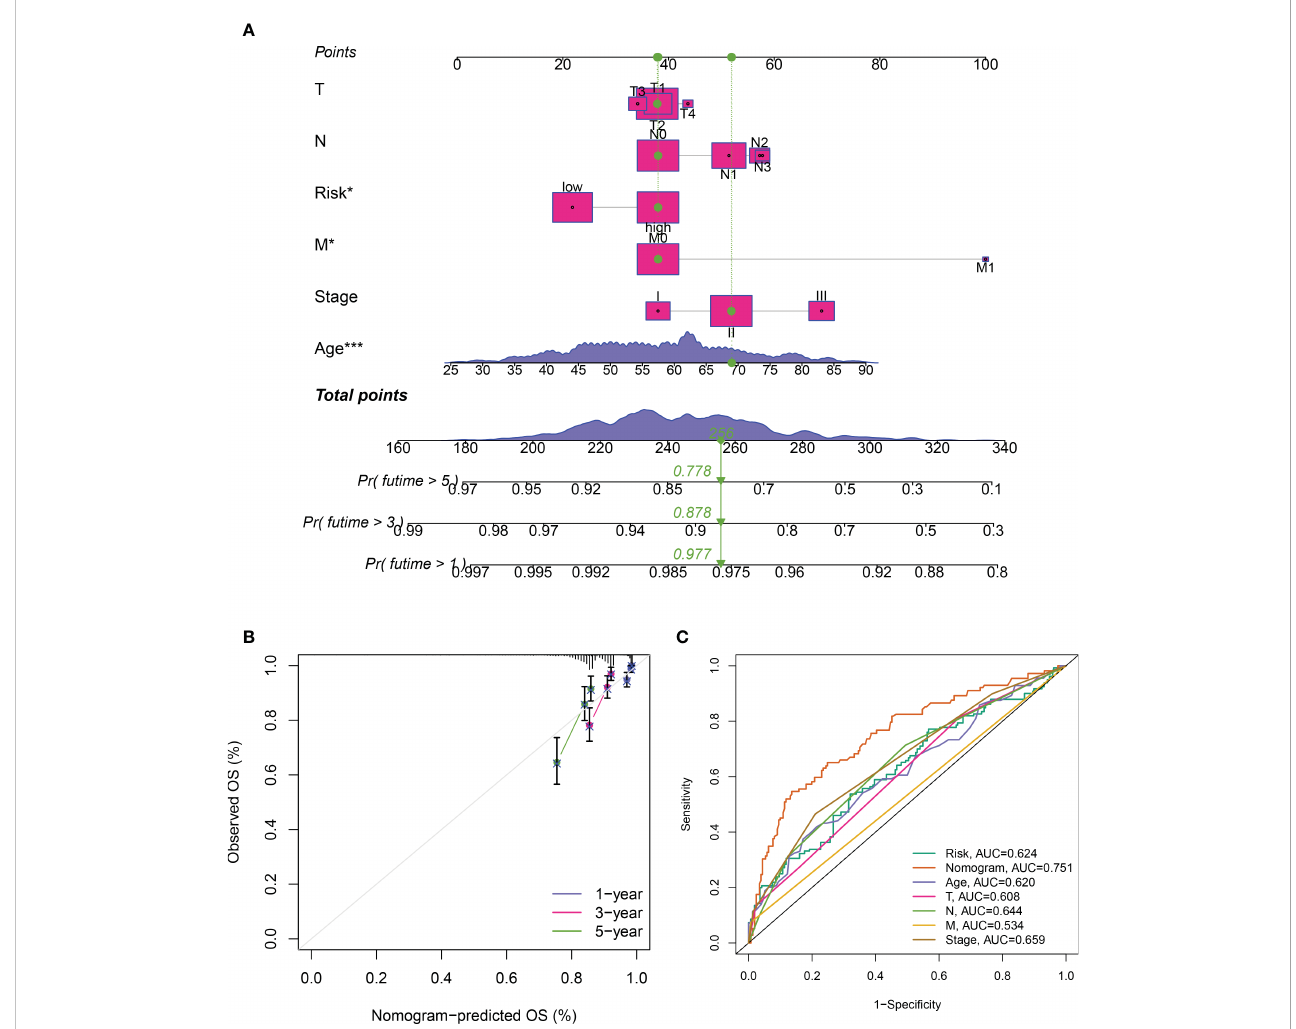
FIGURE 5 Construction of the predictive nomogram. (A) Predictive nomogram of the risk signature and clinicopathological characteristics. (B) Calibration curve of the nomogram for 1/3/5-year survival rates. (C) Time-dependent ROC curves for overall survival prediction of ICDRGs risk model and clinicopathological